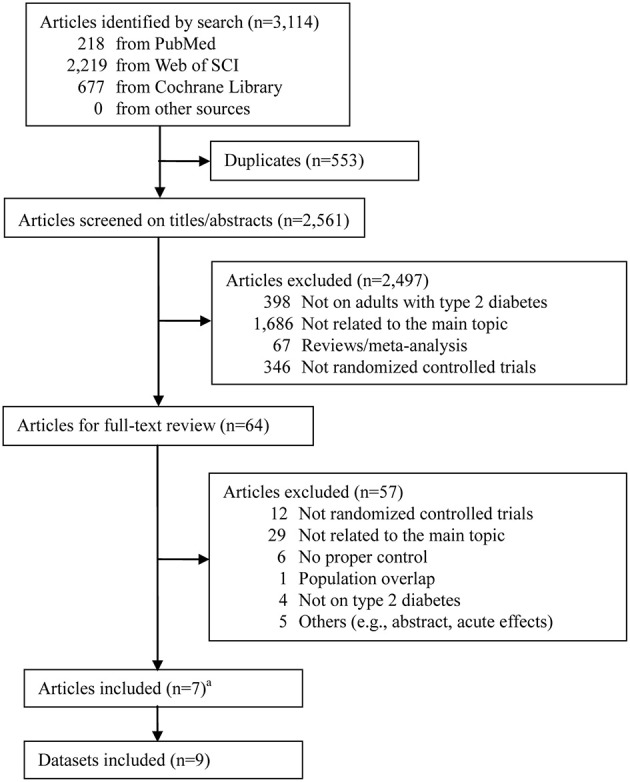
Literature search flow. a Two articles Karstoft et al. (2013) and Mitranun et al. (2014) had 2 control groups each.